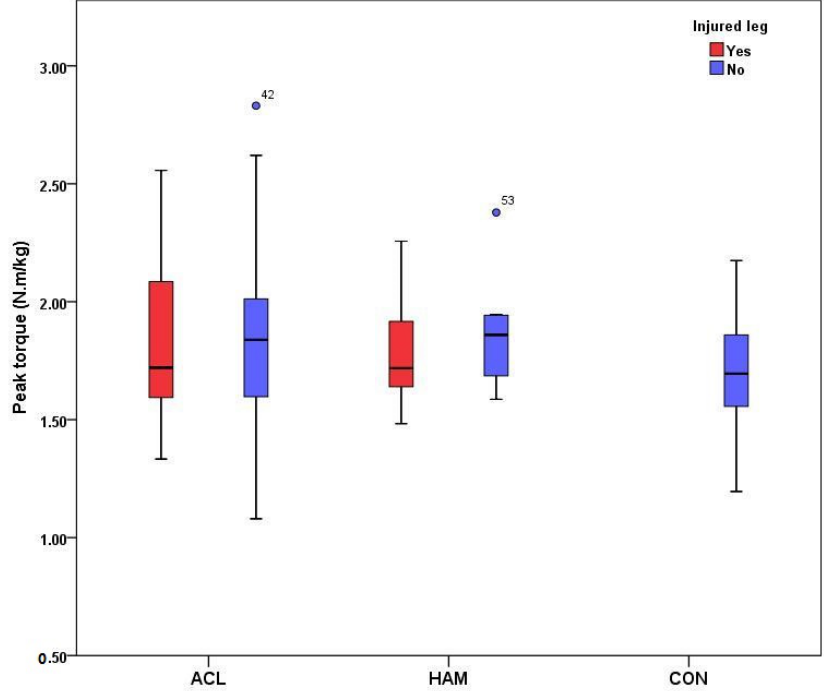
Figure 2. Comparison of knee flexor’s peak torques between observed groups. Note: ACL = anterior cruciate ligament group, HAM = hamstring group, and CON = control group. Table 2. Effect of main factors on the level of knee flexor strength.